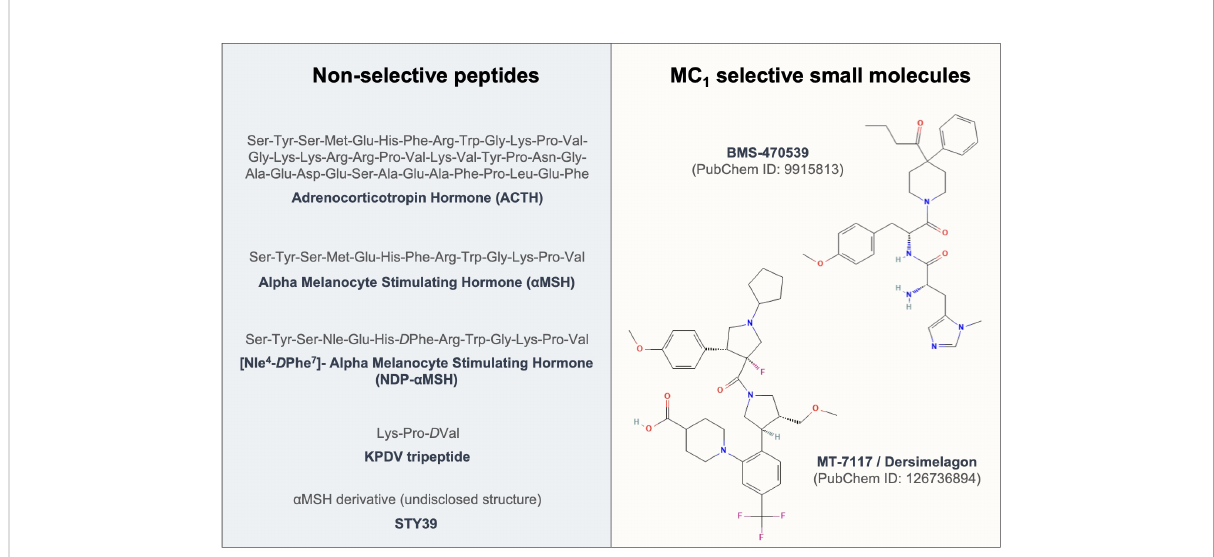
FIGURE 3 Sequences and structures of melanocortin drugs tested in fi broblasts and related diseases. The amino acid sequences and chemical structures of the melanocortin agonists that have been tested using in vitro and in vivo models of diseases mediated by fi broblasts included in Tables 1, 2 are